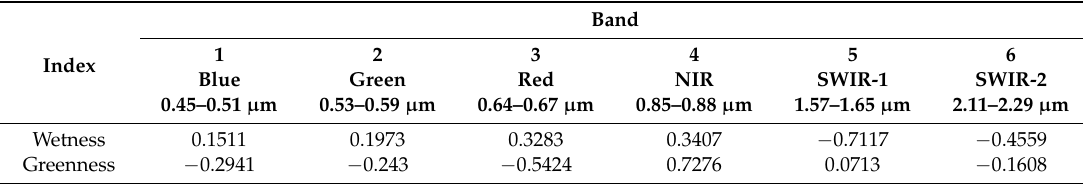
Table 2. Tasseled cap transformation coefficients for Landsat 8 OLI